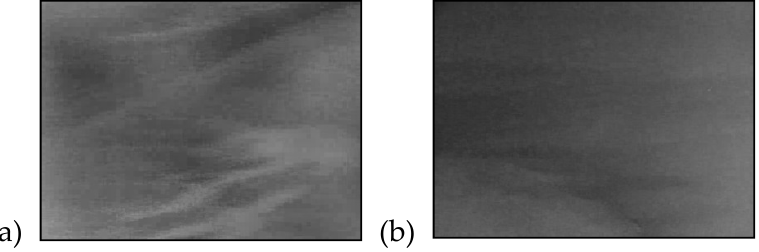
Figure 17. Verification of thermal infrared images. The dark areas in ( a , b ) are oil films.